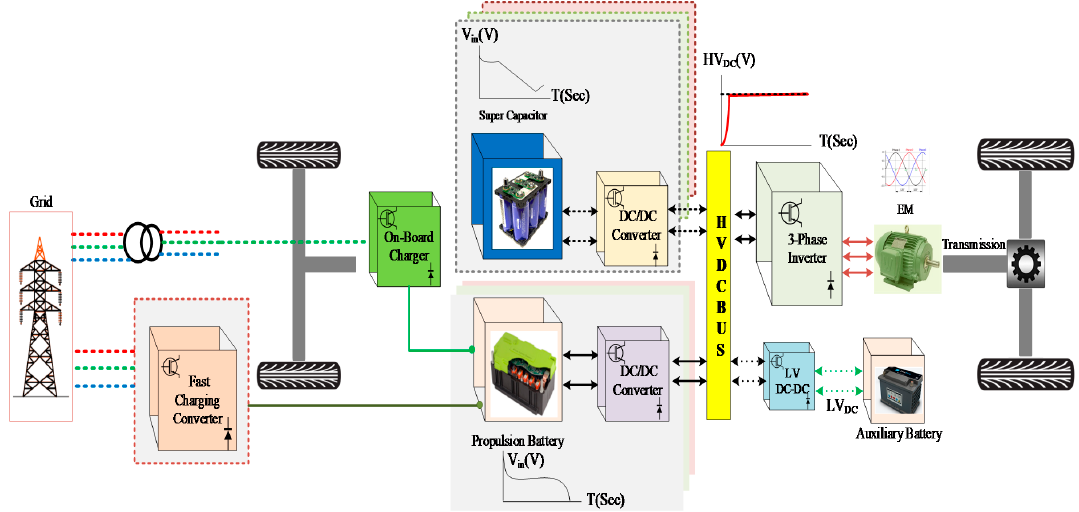
Figure 3. Block diagram of an electric vehicle powertrain.